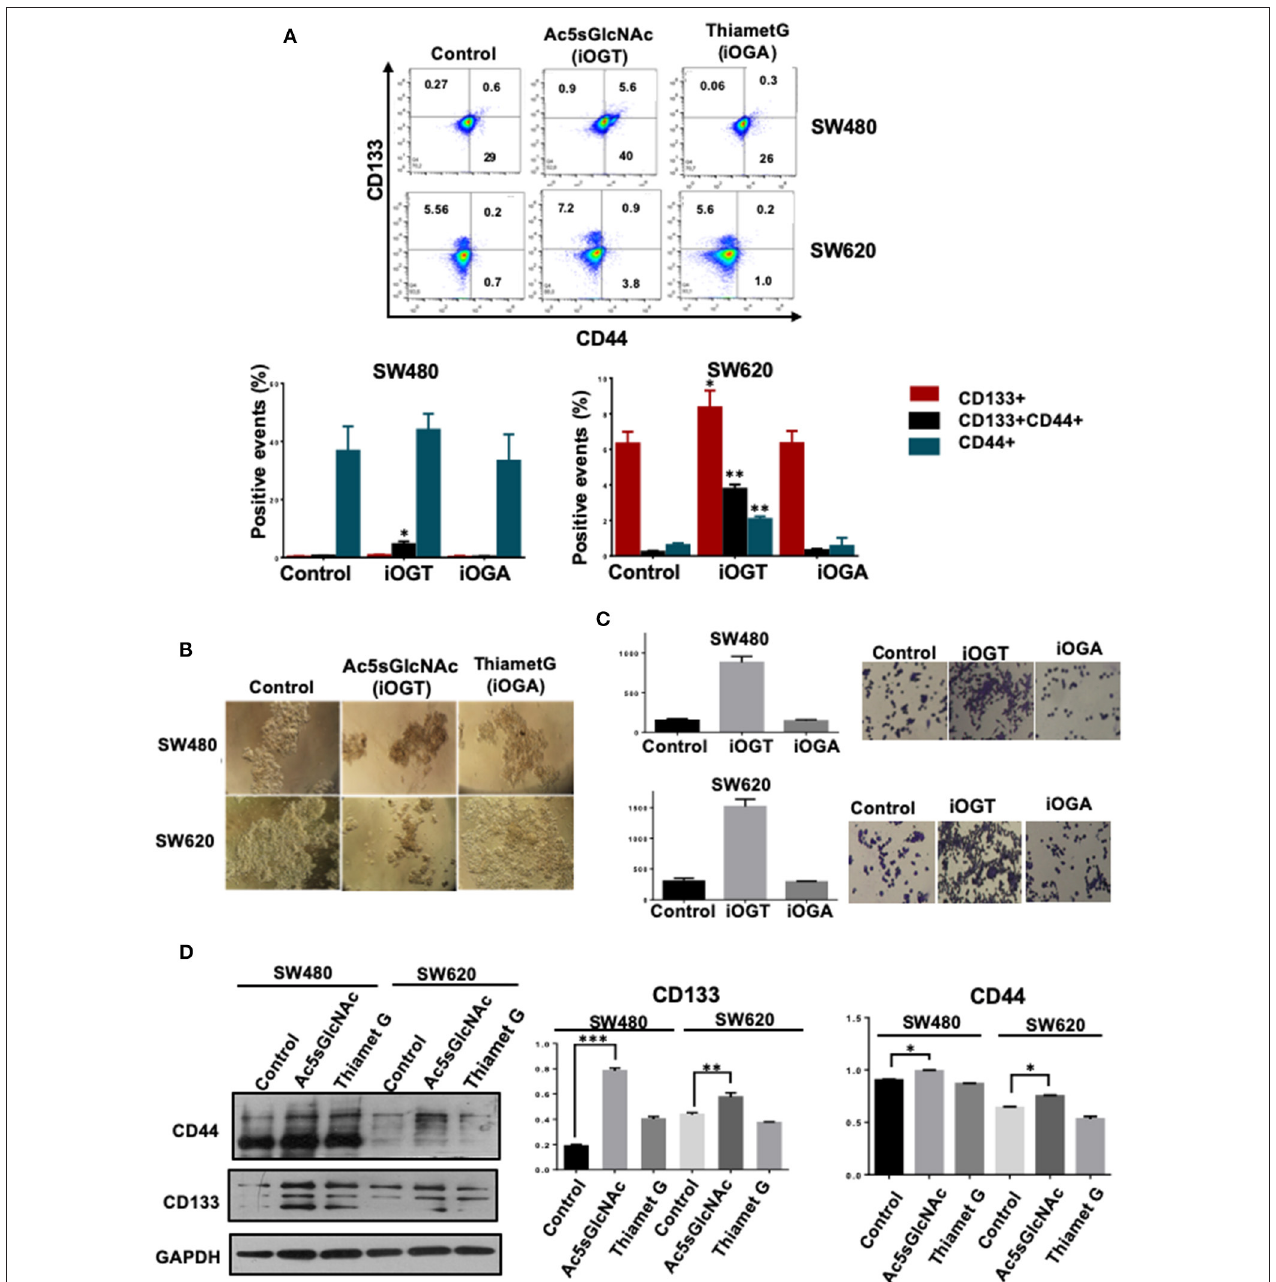
FIGURE 4 | Inhibition of OGT promoted changes in the expression of CD44 + CD133 + cancer stem cell markers. Cell were incubated 24 h in the absence (DMSO as vehicle) or presence of 50 M Ac5sGlcNAc to decrease the levels of O-GlcNAc, or in the absence (vehicle DMSO) or presence of 1 M Thiamet G to inhibit OGA and increase them. (A) After 24 h of inhibition, expression of CD44 + CD133 + and CD44 + CD133 + subpopulations was evaluated by flow cytometry. The data represent the means ± SEM from at least three independent assays * p = 0.01; ** p = ( t -test) compared with control. (B) Cells Spheroid culture. Total cell populations were cultured in ultra-low adherence six-well plates with medium supplemented with EGF and B27. After 2 weeks of incubation pictures of the spheres were taken. (C) Clonogenicity assay. Cells were cultured in DMEM F12 with ITS in the absence or presence of the OGT or OGA inhibitors to evaluate colony formation. Bar graphs shown represent the mean ± SEM of three independent experiments. (D) Western blot showing the expression of CD133 and CD44 on total cell lysates of the spheroid culture. GAPDH were used as a load control. The results shown are representative of at least three independent experiments using different cell preparations. A densitometric analysis of the expression levels found for each marker is shown at the right and the data represent the means ± SEM from at least three independent experiments. * p = 0.01; ** p = 0.005; *** p = 0.001 ( t -test) compared with control 112CoN non-malignant cells.